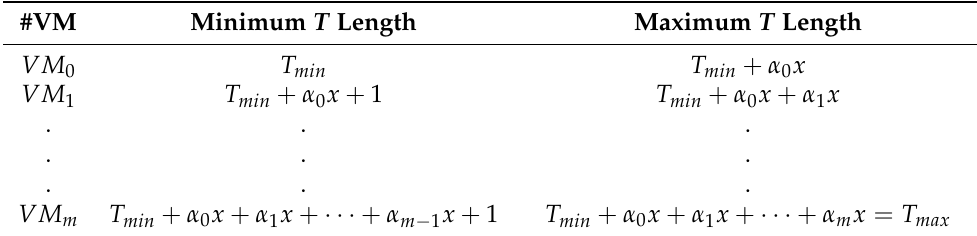
Figure 4. Range distributions of cloudlets among VMs. Table 2. The acceptability ranges of the cloudlet